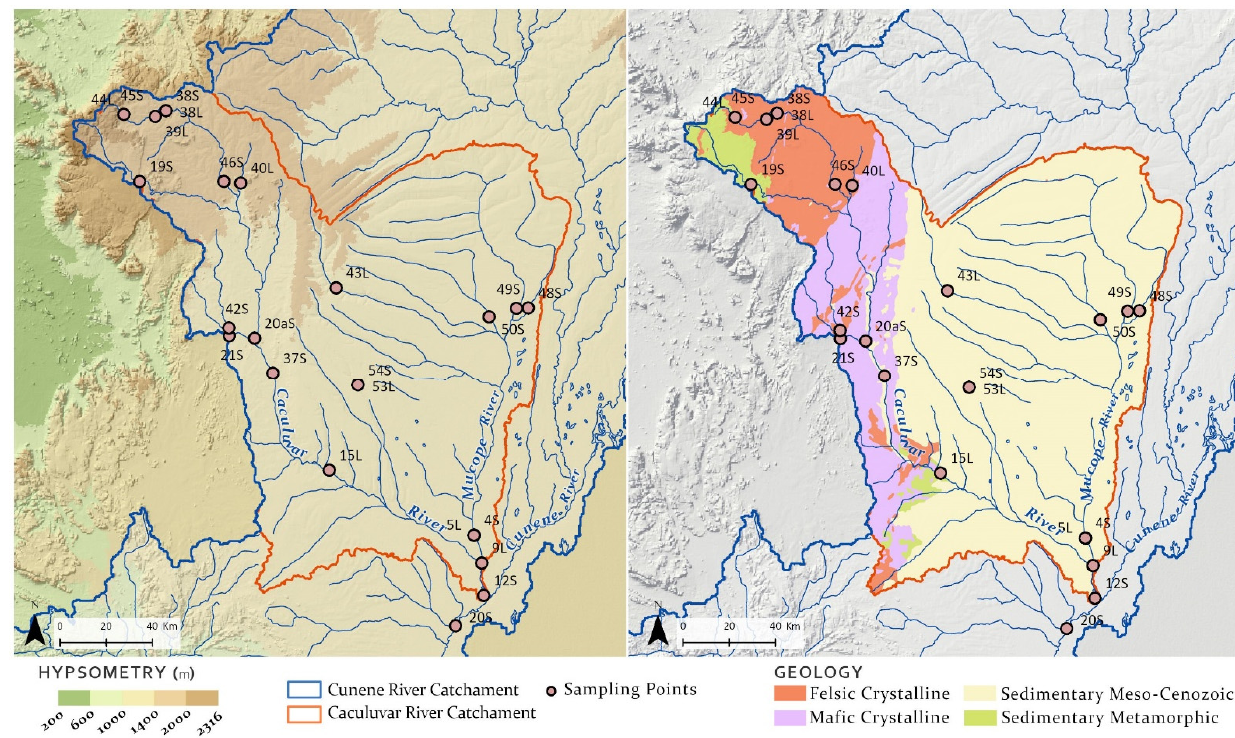
Figure 2. Sampling sites and the orography ( left panel ) and geology ( right panel ) of their source areas. Geology is based on the Geological Map of Angola, scale 1/1,000,000, sheet 3 [22] .